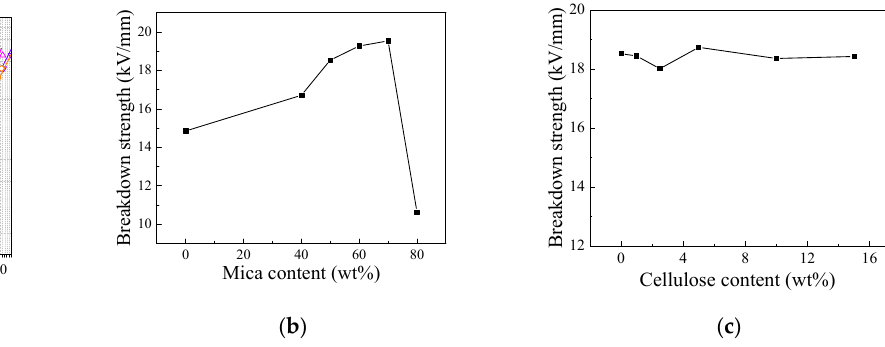
Figure 4. Breakdown strength of the mica composites ( a, b ) and mica/chitosan/nanocellulose composites ( c ).